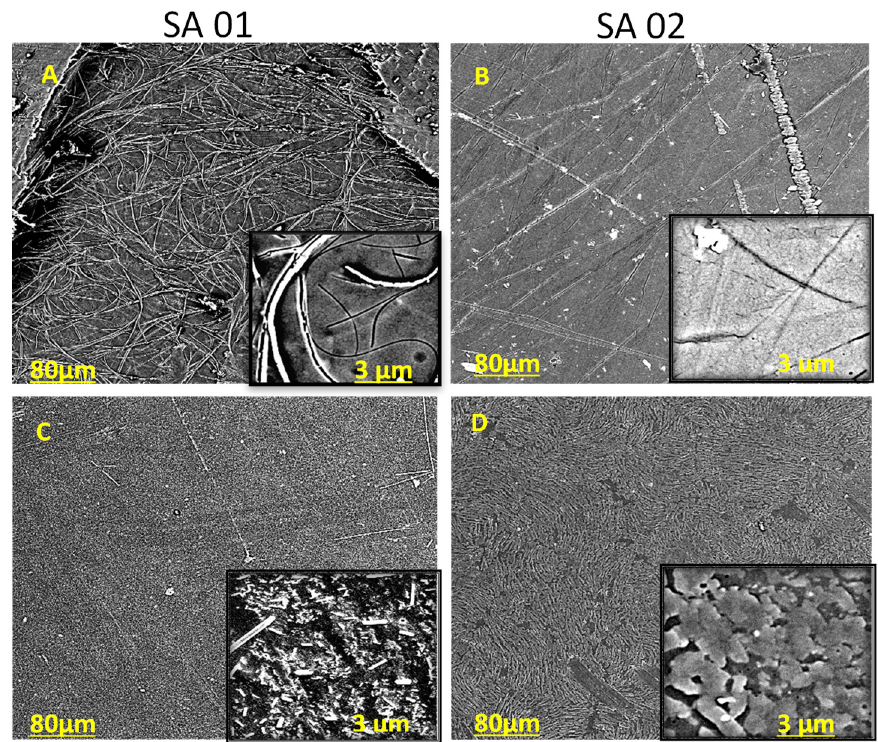
Figure 6. ( A – D ): Surface Images of ( A ) SPEEK SA-01 film of DS = 61.6% loaded with nalidixic acid sodium salt, ( B ) SPEEK SA-02 film of DS = 98.9% loaded with nalidixic acid salt, ( C ) SPEEK film (SA-01) with ciprofloxacin and ( D ) SPEEK film (SA-02) with ciprofloxacin SEM image at magnification 40.0 K X and 200 nm.